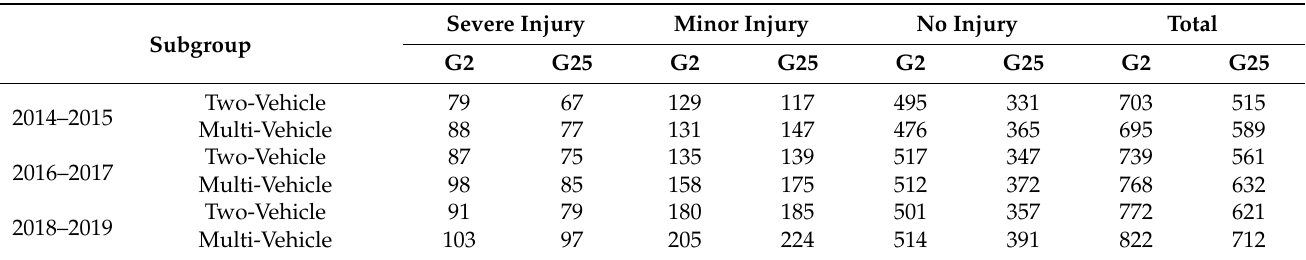
Table 3. Two-vehicle and multi-vehicle rear-end crashes statistics in Beijing-Shanghai Freeway (G2) and Changchun-Shenzhen Freeway (G25) over